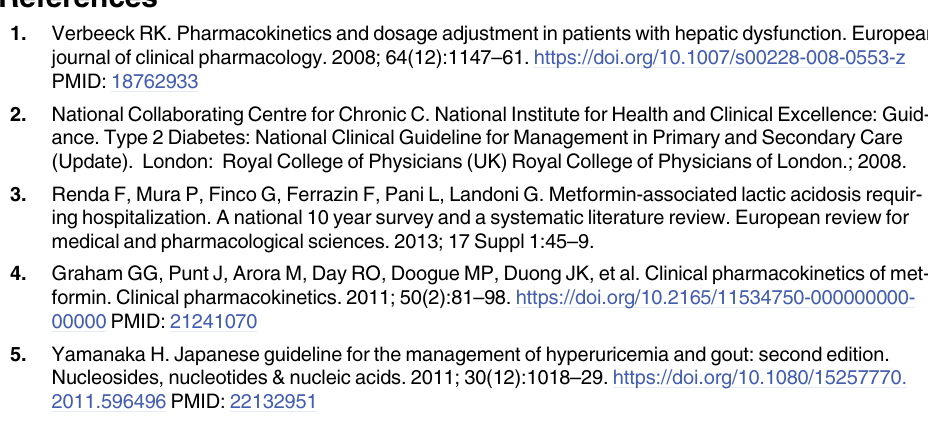
S8 Table. Pharmacokinetic parameters of cephalexin in control rats after intravenous administration of cephalexin (dataset of Table 3). S9 Table. Protein expression level of kidney Mate1 in control and hyperuricemic rats (dataset of Fig 5). S10 Table. Effects of oxonic acid, adenine and uric acid on uptake of MPP + by MATE1-ex- pressing cells (dataset of Fig